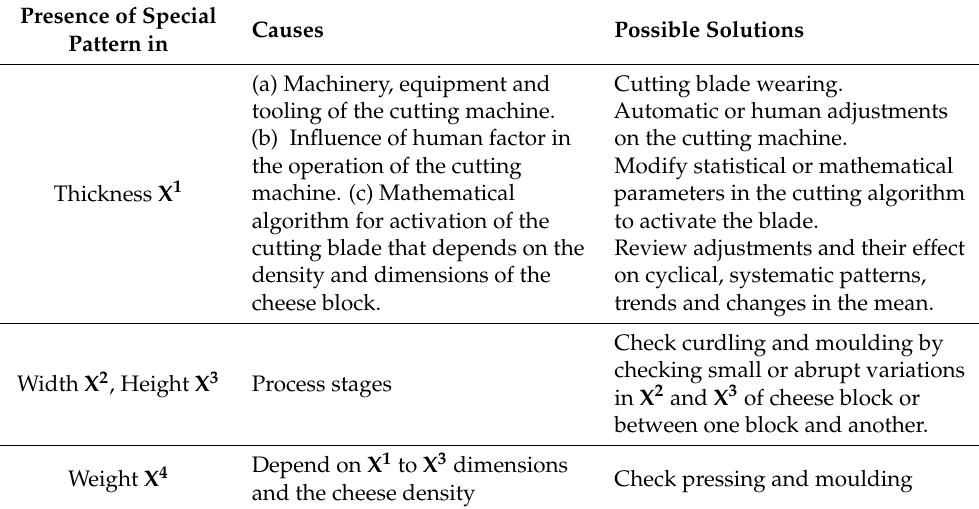
Table 5. Summary of causes and possible